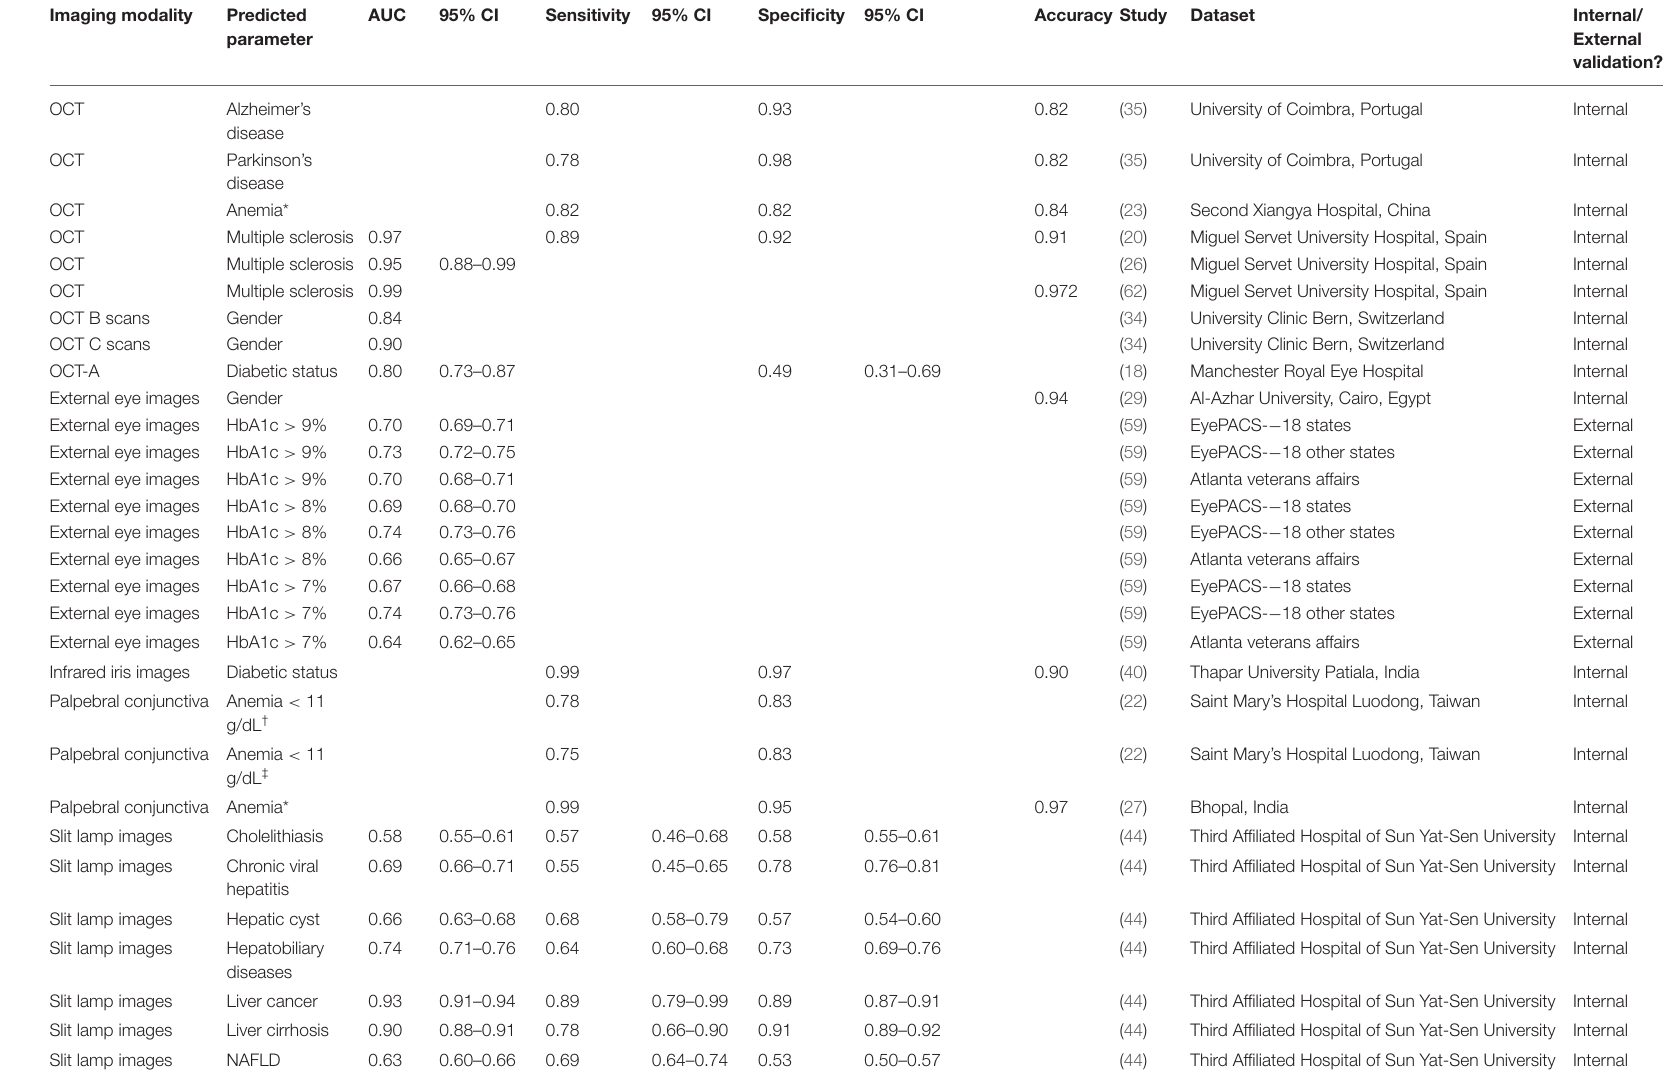
TABLE 2 | Performances of OCT or external eye imaging AI models in predicting systemic disease and